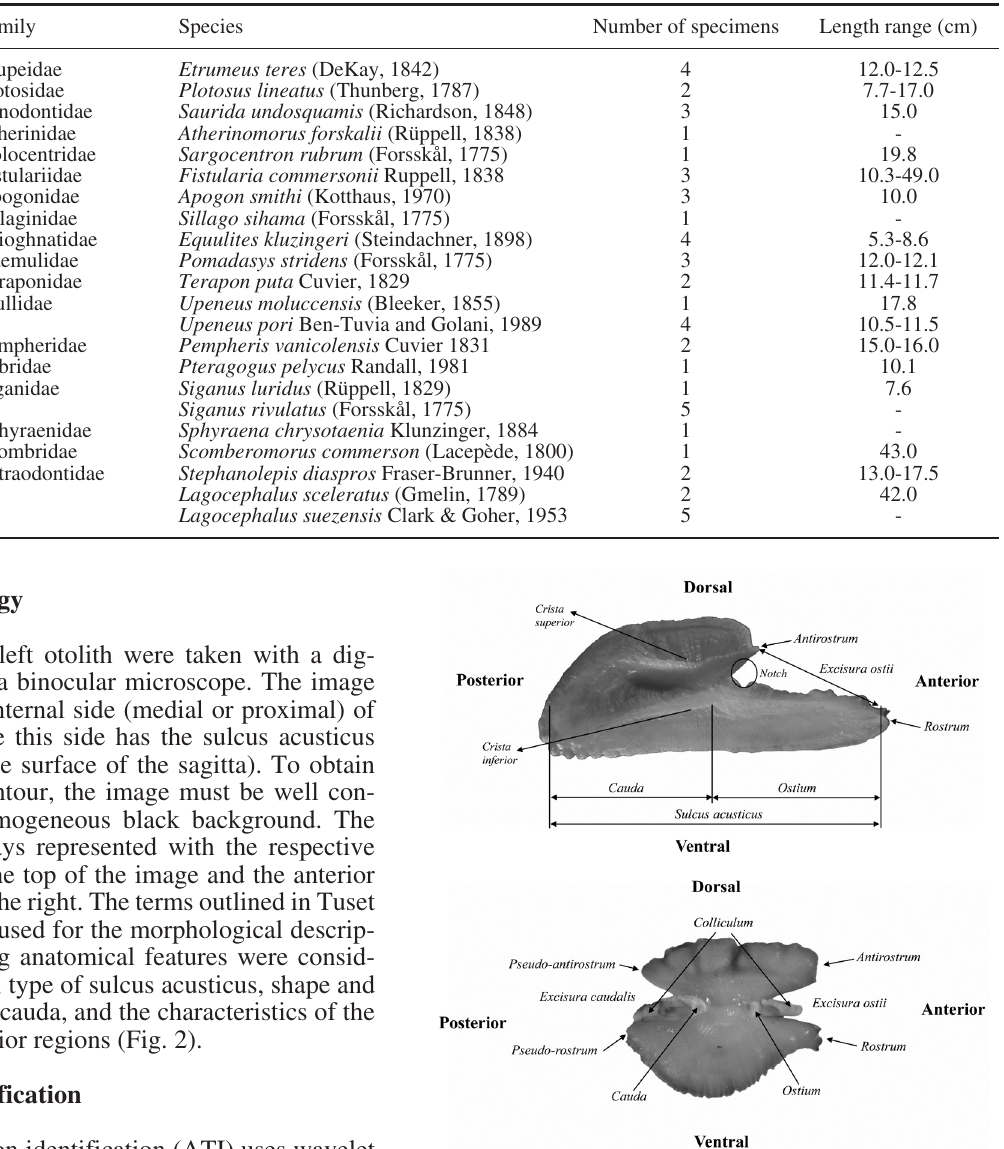
F ig . 2. – Anatomical features of otoliths used for the morphological descriptions (from Tuset et al .